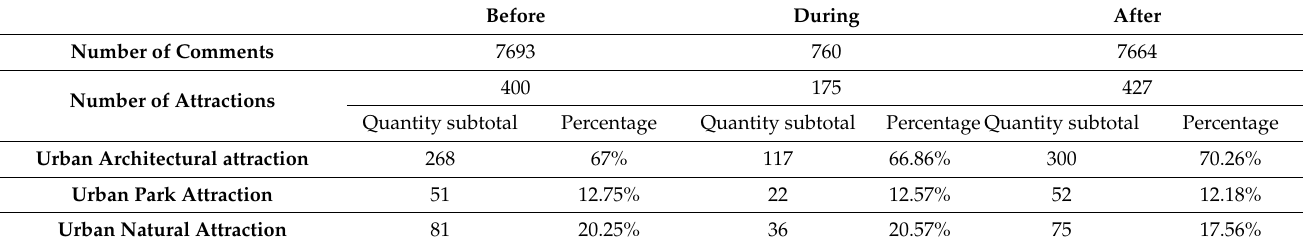
Table 3. Data statistics of comparative groups and attractions clusters.